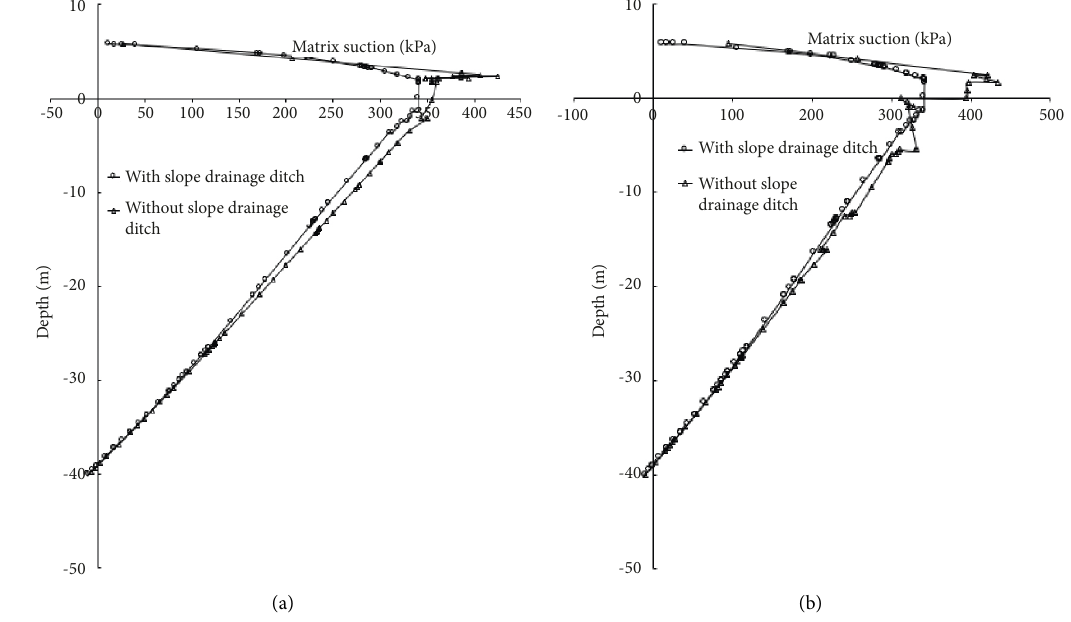
Figure 12: Influence of drainage conditions on pore water pressure. (a) There is no drainage groove. (b) There is no drainage-side